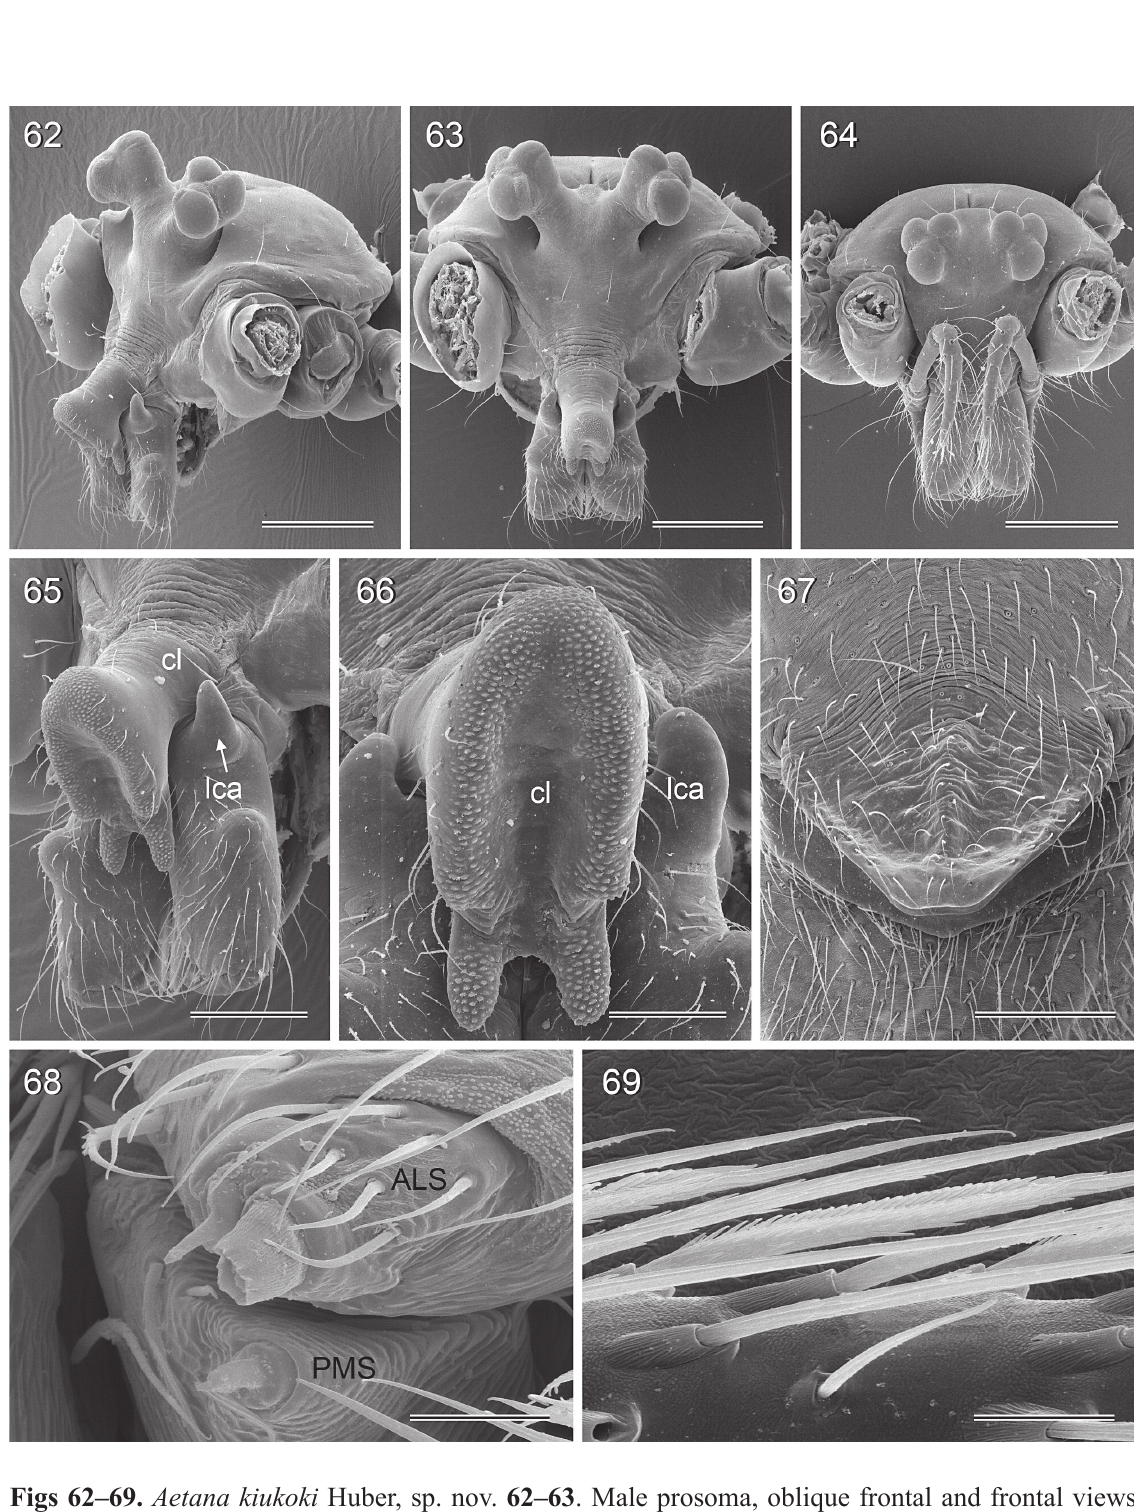
Figs 62–69. Aetana kiukoki Huber, sp. nov. 62–63 . Male prosoma, oblique frontal and frontal views. 64 . Female prosoma, frontal view. 65 . Male clypeus and chelicerae, oblique frontal view. 66 . Male clypeus modification, frontal view. 67 . Epigynum, ventral view. 68 . Male ALS and PMS. 69 . Comb-hair on female tarsus 4. cl = clypeus; lca = lateral cheliceral apophysis. Scale lines: 62–64 = 400 µm; 65, 67 = 200 µm; 66 = 100 µm; 68–69 = 20